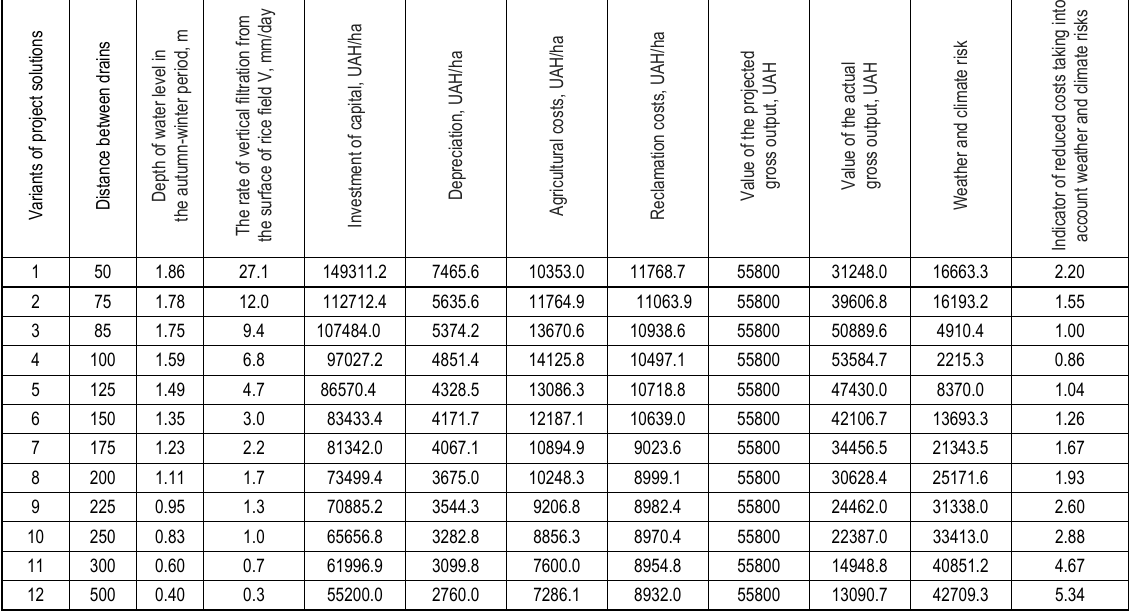
Table 1. The main results of optimization of calculations for the Danube region’s rice irrigation systems regarding substantiation of the optimal parameters of drainage on rice fields